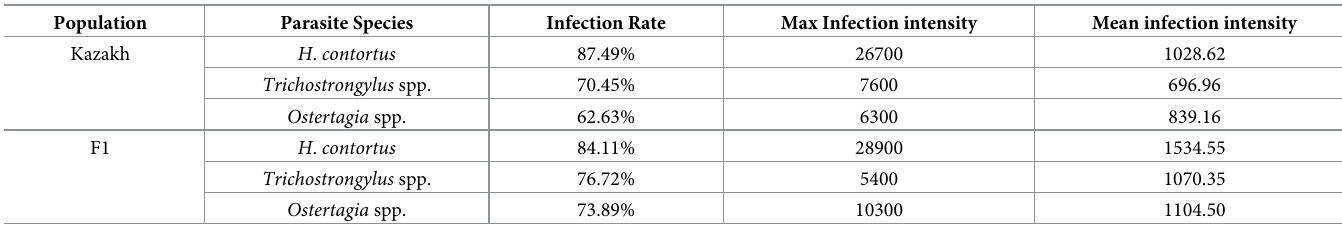
Table 7. Dominant species of sheep GINs in spring.